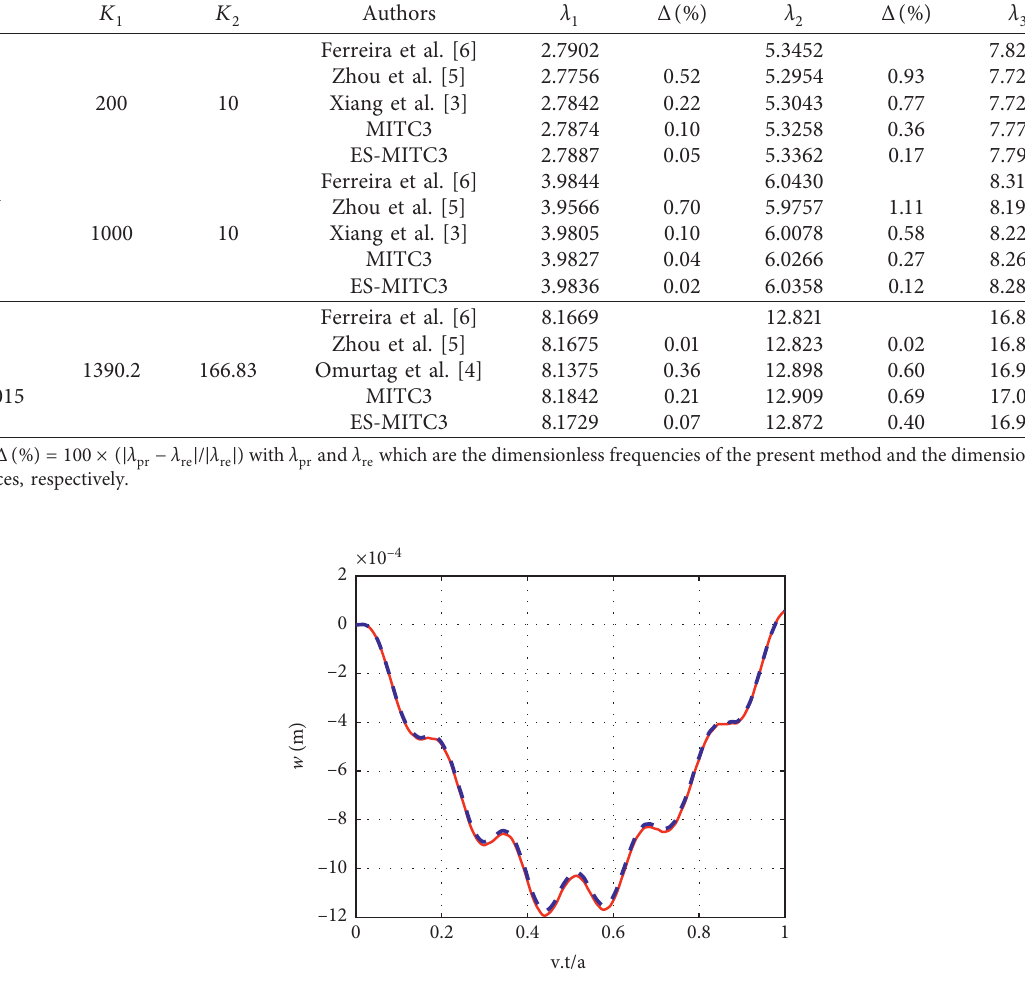
Table 1: Dimensionless frequencies of plates.